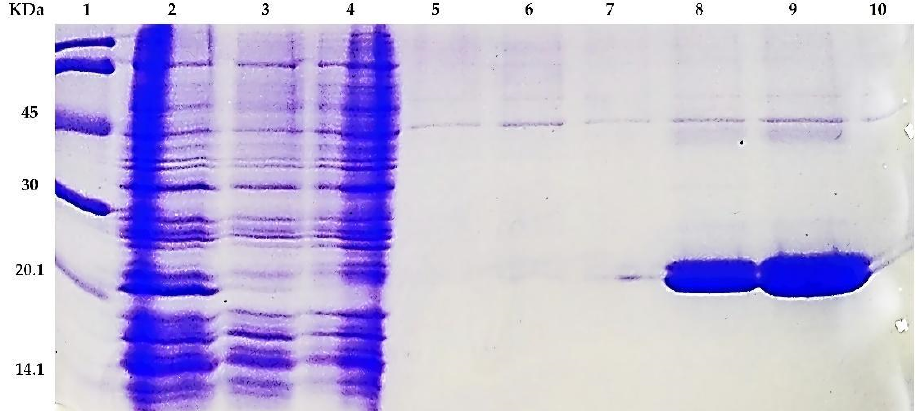
Figure 4. Expression and purification of MAP3773c in E. coli . SDS-PAGE electrophoresis of the purified MAP3773c recombinant protein. Lane 1, molecular weight marker; Lane 2, filtered extract; Lane 3, filtered extract passed through the column; Lane 4, Wash 1; Lane 5, Wash 2; Lane 6, Elution 1; Lane 7, Elution 6; Lane 8, Elution 11; Lane 9, Elution 16; Lane 10, Elution 21. The concentration of MAP3773c determined by the Bradford method was 1.15